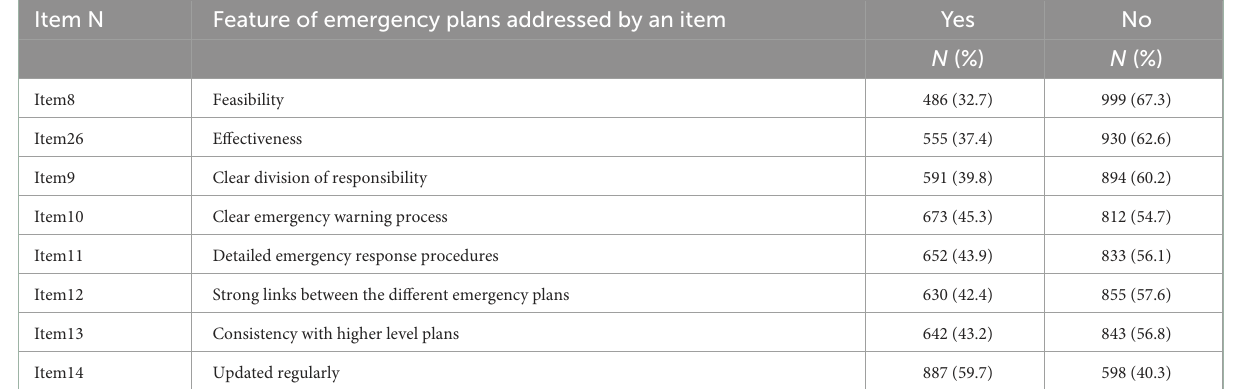
TABLE 2 Questionnaire responses to items about the “ideal